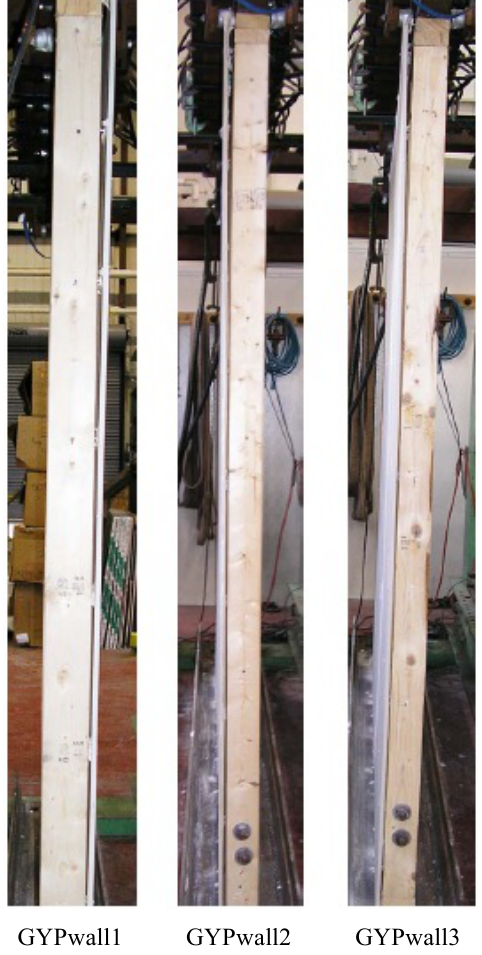
Figure 16. Separation of Gypsum Wallboard from Wood